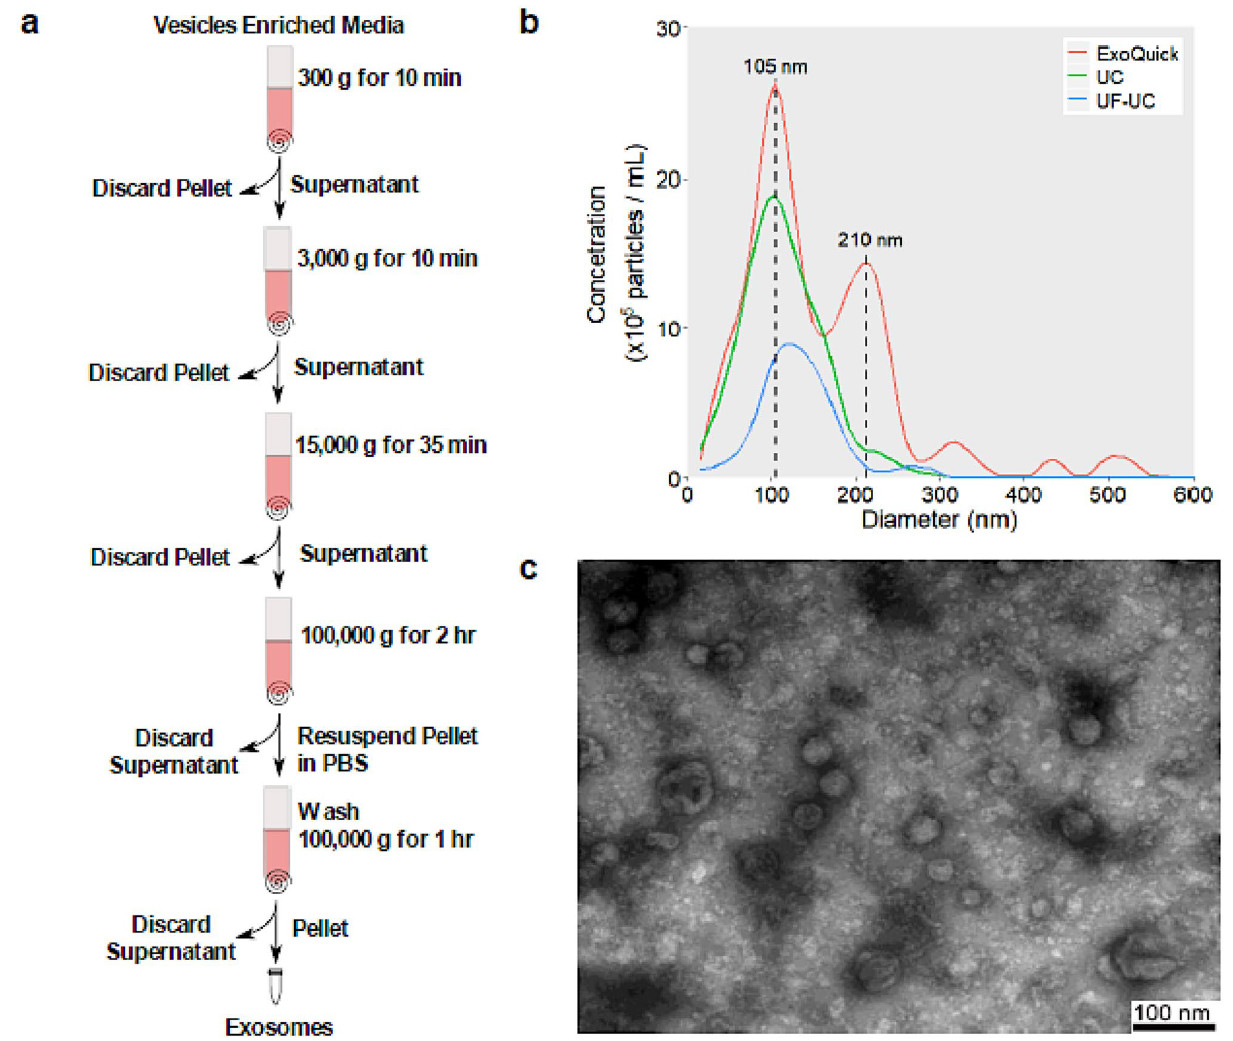
Figure 1. ( a ) Exosome UC isolation protocol. ( b ) NTA analysis of exosomes isolated by ExoQuick (red), UC (green), and UF–UC (blue). ( c ) TEM images of exosomes isolated using the UC method show particles of an average size of 45.5 nm and a size range of 29–86